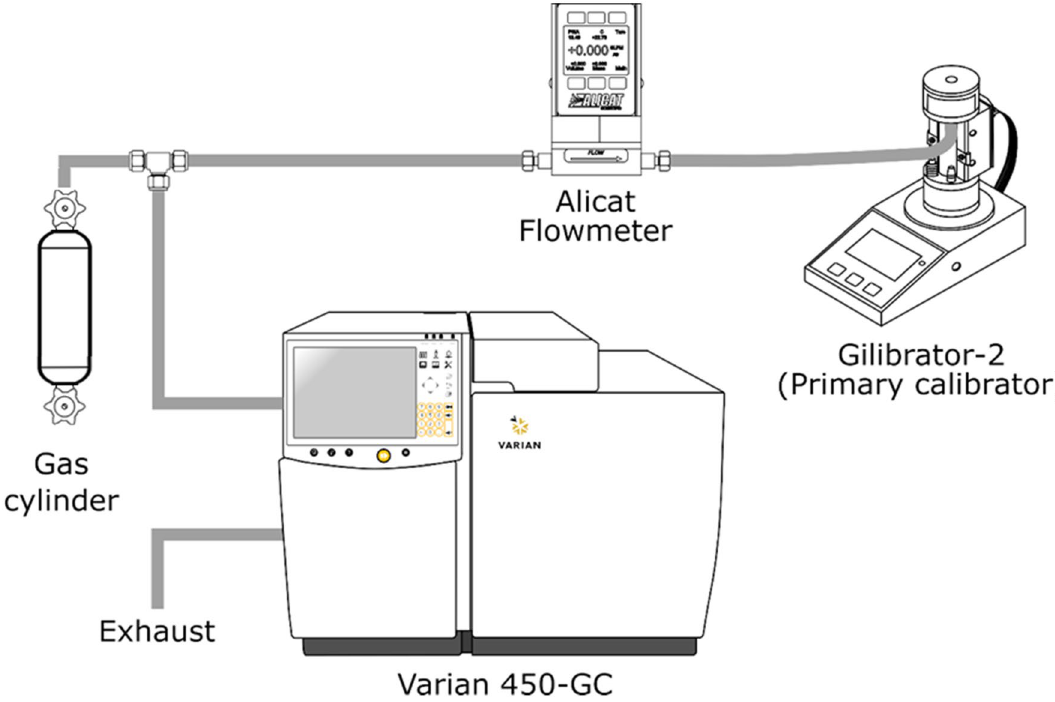
Figure 1. Scheme of the experimental